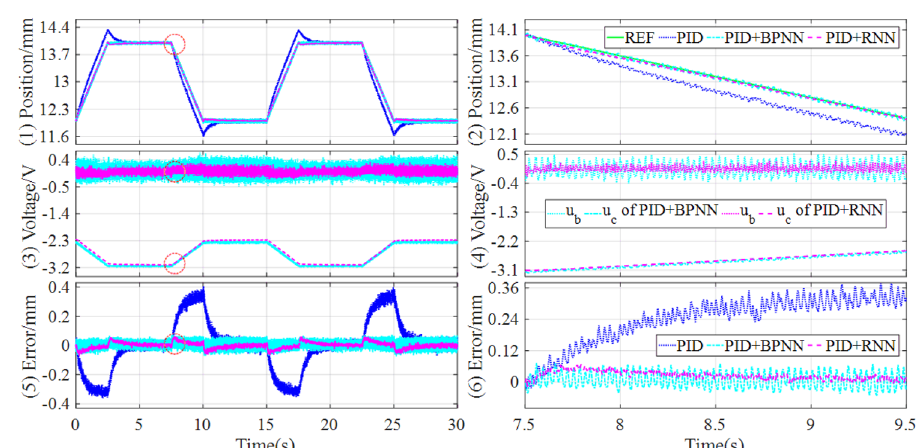
Figure 14. Experimental results of tracking trapezoidal signal under the different